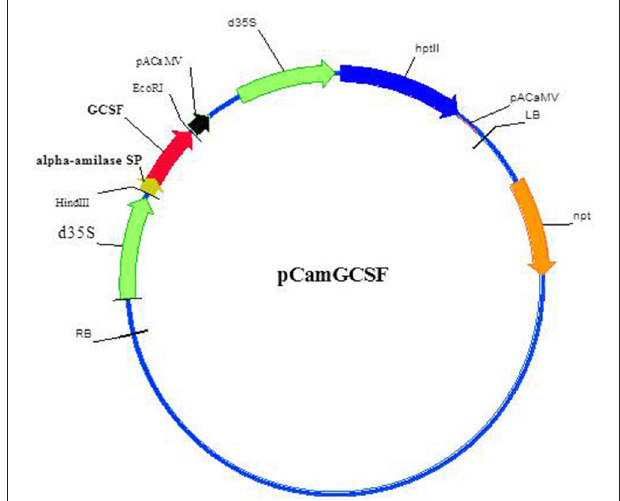
FIGURE 2 | Schematic presentation of pCamGCSF plasmids used for Wolffia transformation. d35S, double 35S RNA Cauliflower Mosaic Virus promoter; GCSF , human granulocyte colony-stimulating factor coding sequence; alpha-amilase SP , nucleotide sequence of rice alpha-amylase signal peptide; hpt ll, hygromycin phosphotransferase (HPT) coding sequence; pACaMV, 35S RNA Cauliflower Mosaic Virus terminator with polyadenylation signal; RB, right border; LB, left border; npt , neomycin phosphotransferase (NPT) coding sequence allowing for A. tumefaciens selection.